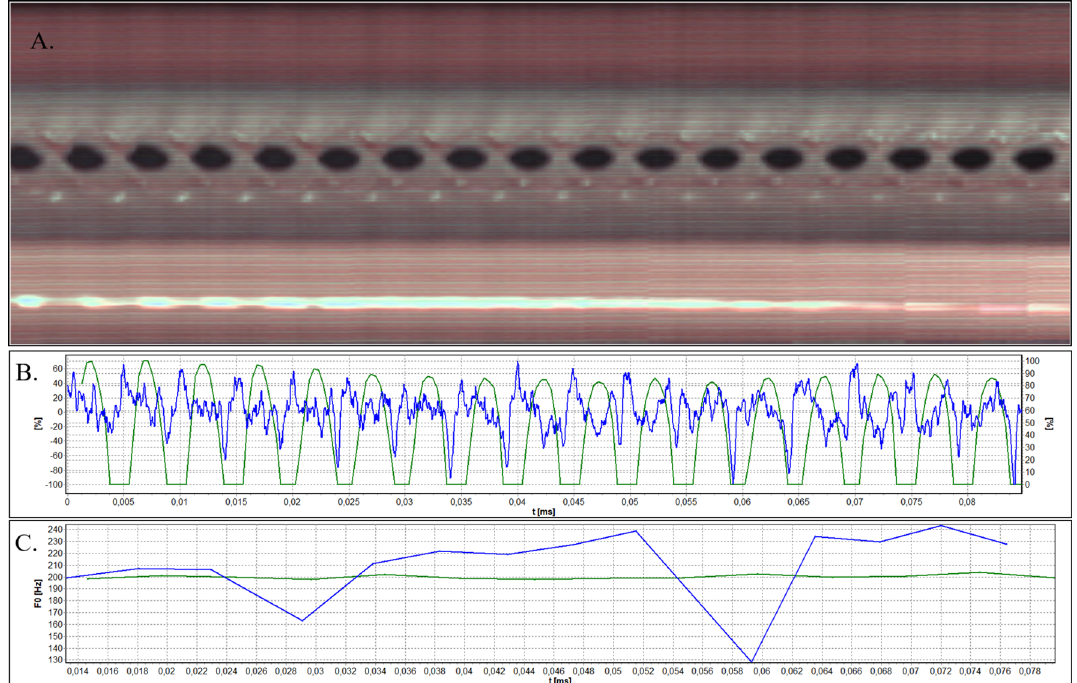
Figure 7. Analysis of HSV data acquired by means of flexible endoscope for Subject 2. ( A ) Videokymogram; ( B ) Comparison of the glottal width waveform obtained from a videokymogram (green line) and the audio signal oscillogram (blue line); ( C ) Comparison of F0 obtained from a videokymogram (green line) and acoustic voice analysis (blue